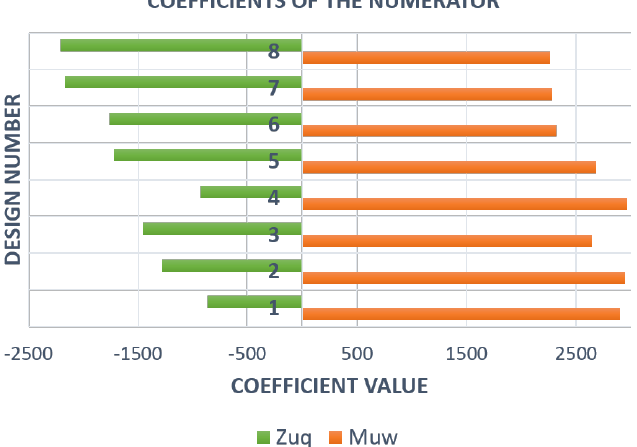
Figure 7. Absolute value of hydrodynamic coefficients contributing to the numerator of the term stability index G V to indicate the main contributors to stability change apart from the mass